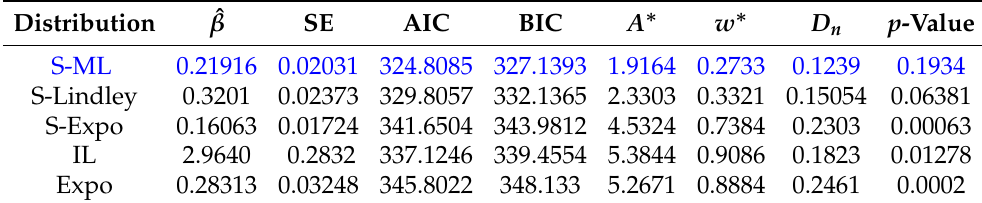
Table 7. ˆ β , SE and GOF metrics of the tumor size of the lung cancer